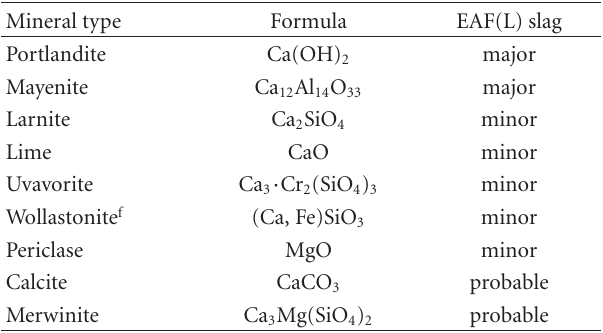
Figure 9: Gravel-size EAF(L) slag particles. Table 6: Mineralogical phases identified in EAF(L) slag based on XRD